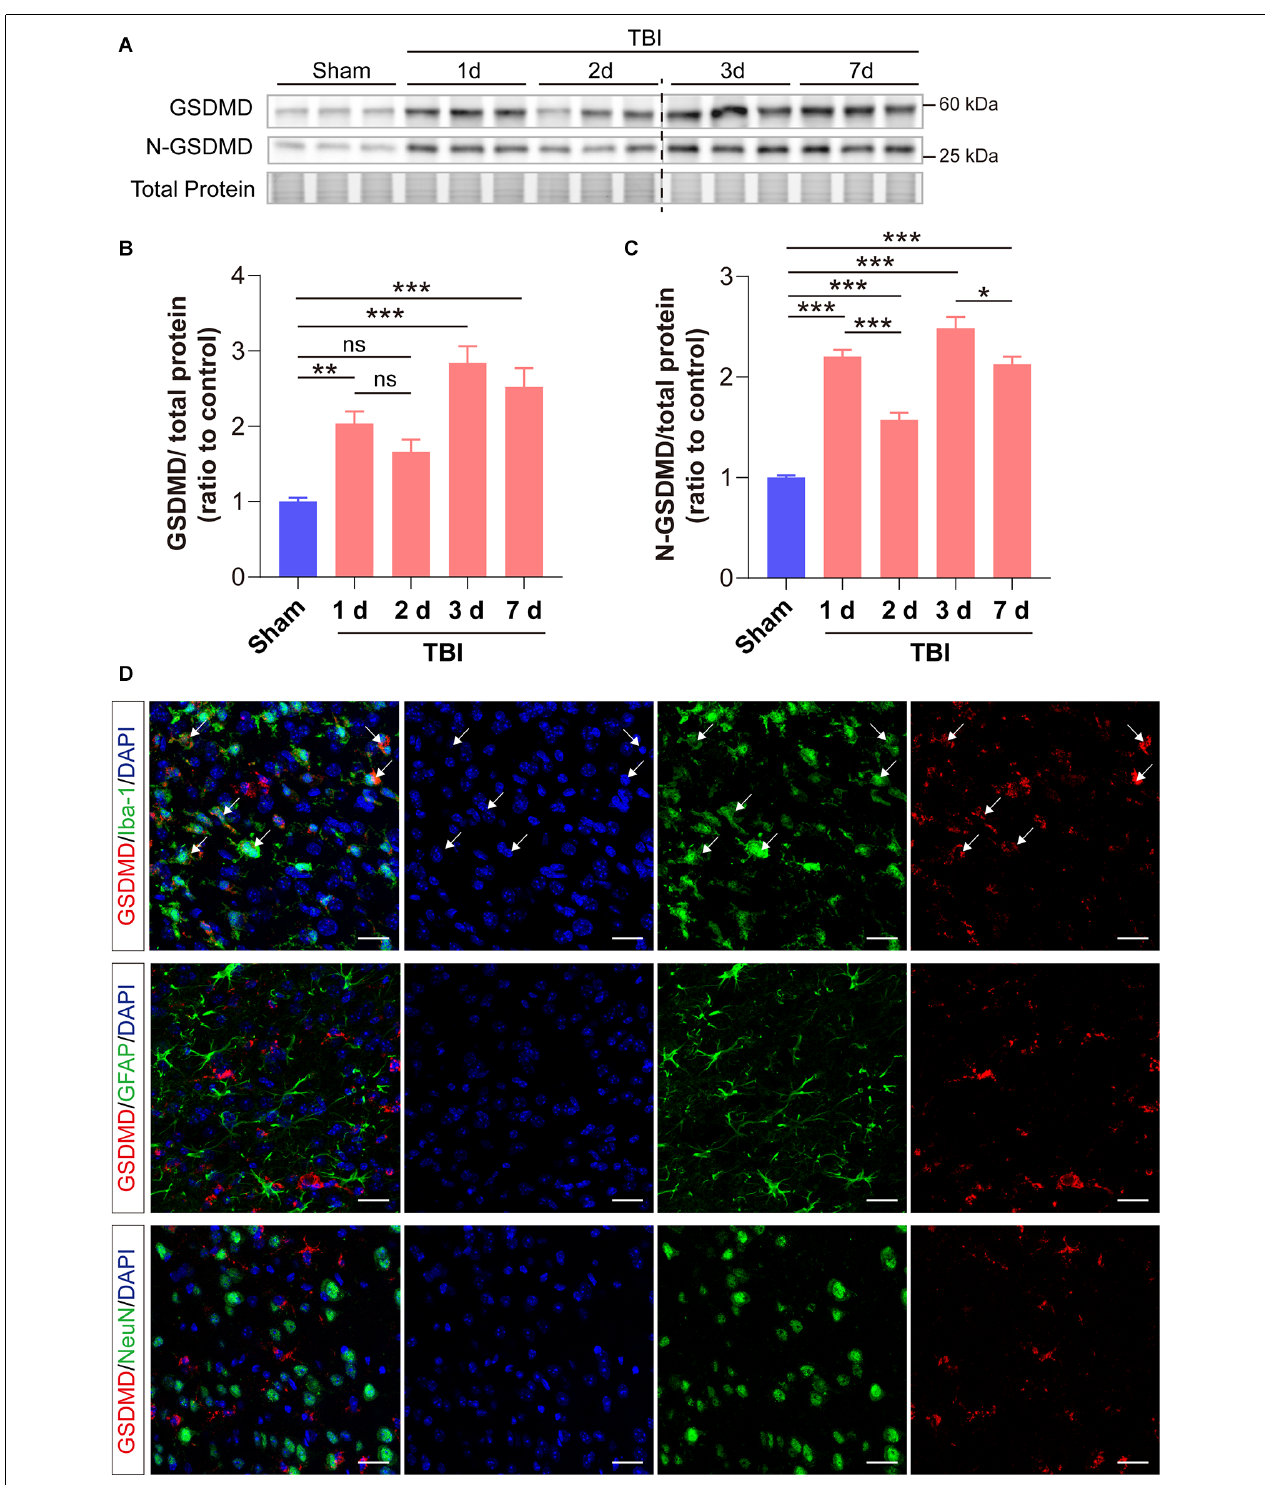
FIGURE 1 | GSDMD increased significantly in the peri-injury cortex after TBI and was mainly localized in microglia. (A) Representative images of immunoblots for GSDMD, N-GSDMD, and total protein. (B,C) Quantitative analysis of GSDMD and N-GSDMD protein levels ( n = 6). (D) Representative immunofluorescence showed the localization of GSDMD (green) with Iba-1, GFAP, and NeuN (red), in the peri-injury cortex at 3 days after TBI. Scale bar = 20 µ m. White arrows indicate GSDMD + and Iba-1 + cells. All data are presented as the mean ± SEM and were analyzed using one-way ANOVA followed by Tukey’s multiple comparisons test for significance. ns p > 0.05, * p < 0.05, ** p < 0.01, and *** p <